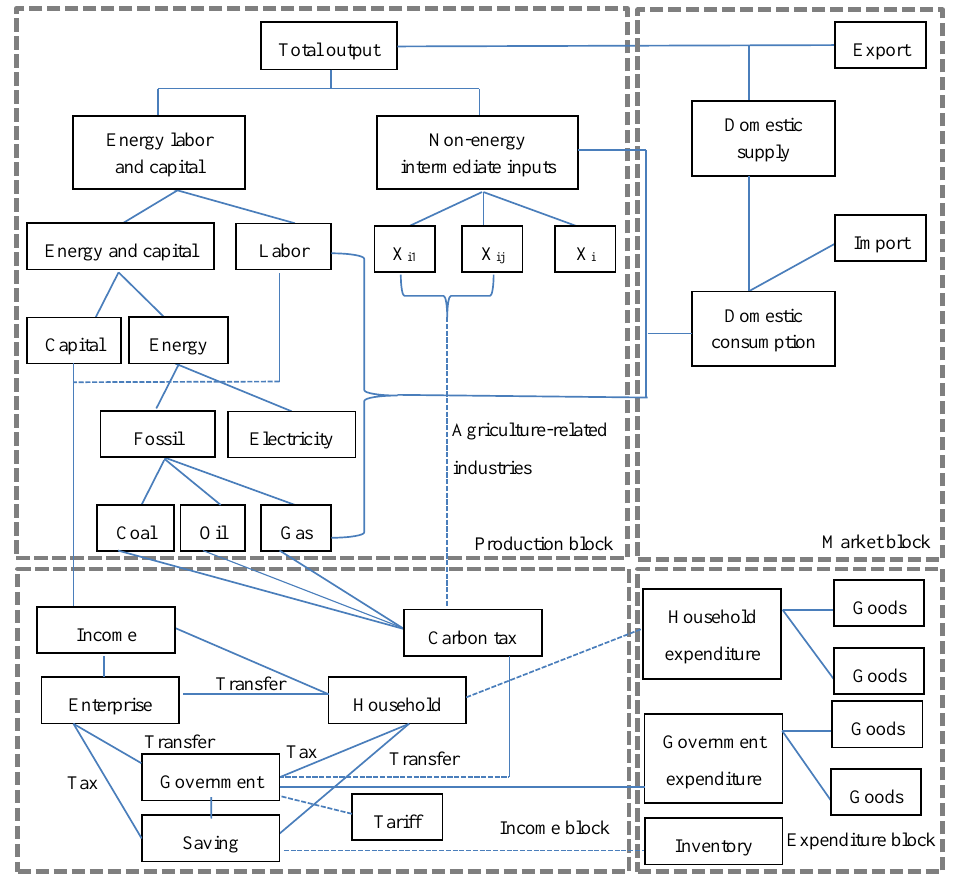
Figure 1. General structure of the economy-energy-environmental-agricultural-dynamics CGE model (3EAD-CGE) model in Chinese agriculture-related sectors.